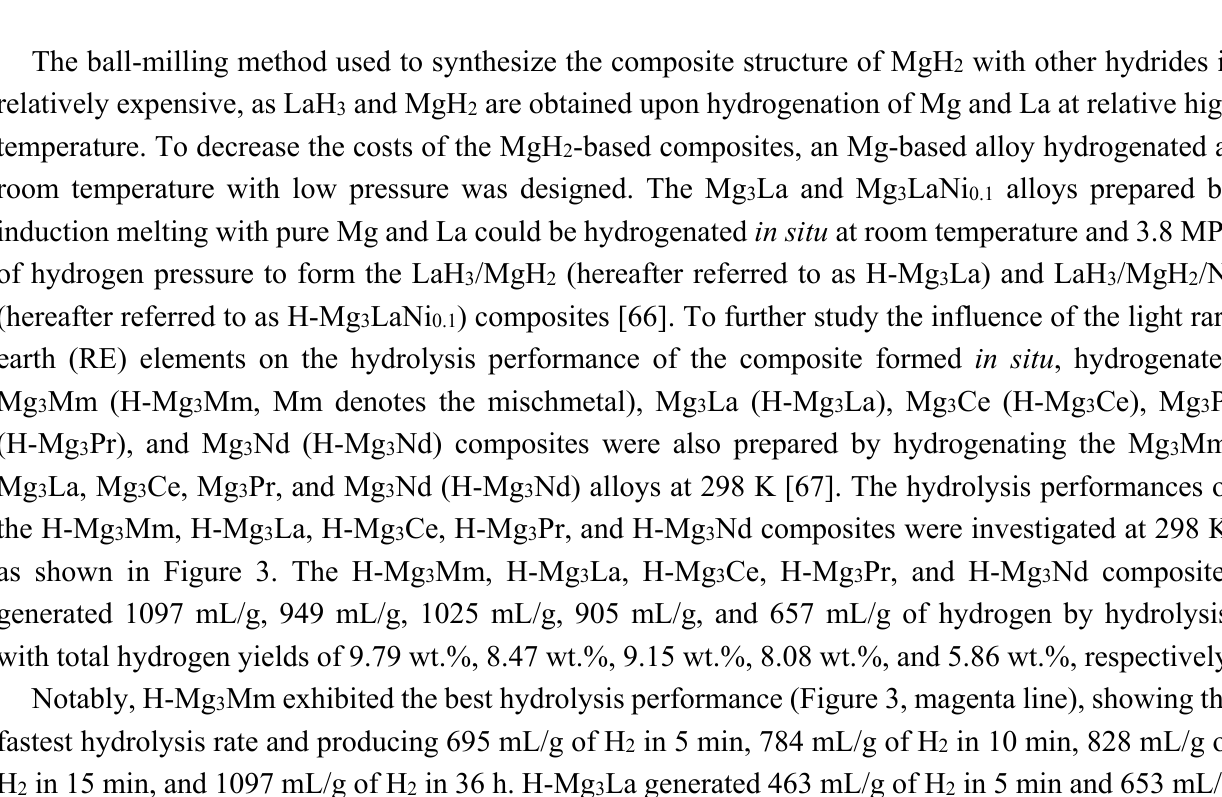
Figure 2. The hydrogen generation curves of ball-milled MgH 2 and LaH 3 with different atomic